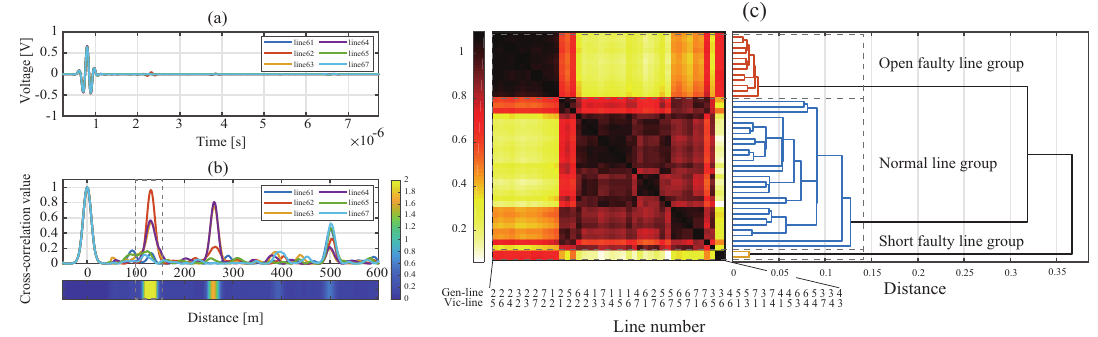
Figure 8. Fault detection and classification results with the Line 6 as the generator line. ( a ) TFDR reflected signals, ( b ) TFCC and ANN results and ( c ) heat-map representation and hierarchy clustering results on TFDR